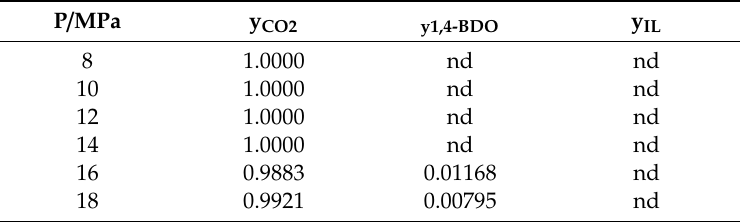
Figure 2. Vapour-liquid equilibrium studies for the quaternary • , CO 2 + 1,4-BDO + [hmim][B(CN) 4 ] + H 2 O [this work] and binary × , CO 2 + 1,2-BDO and + , CO 2 + 1,3-BDO (Reproduced with permission from [27] Copyright Elsevier, 2004), ○ , CO 2 + [hmim][B(CN) 4 ] (Reproduced with permission from [24] Copyright Elsevier, 2016) systems, at 313,15 K; the right hand side represents an enlargement of the gas phase regime. Table 2. Vapour-liquid equilibrium data for the ternary (CO 2 + 1,4-BDO + [hmim][B(CN) 4 ]) system at 313.2 K 1 (data presented refer to the gas